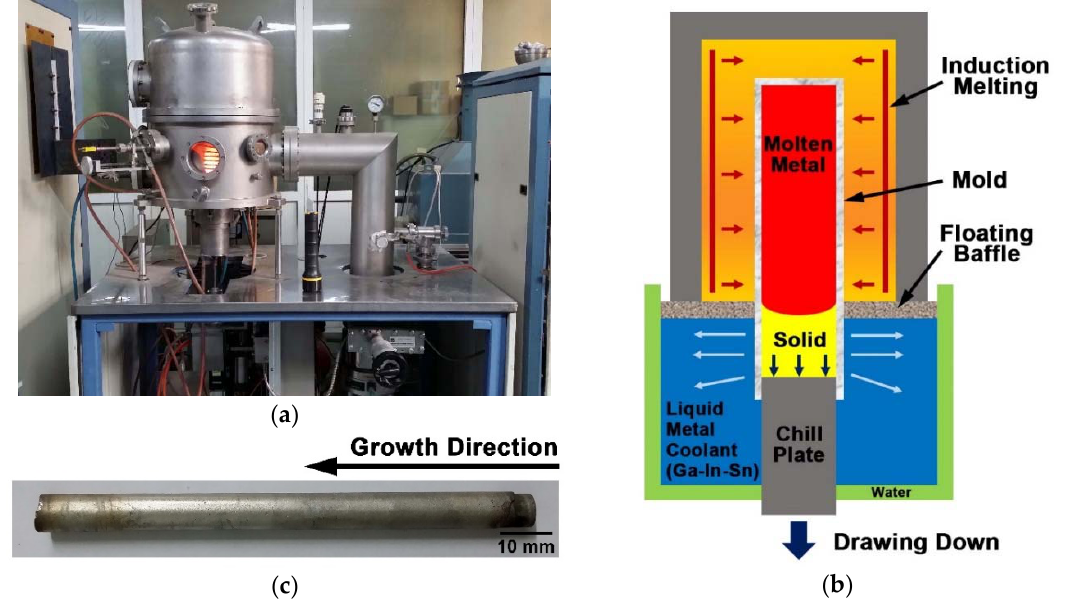
Figure 1. ( a ) Appearance and ( b ) schematic illustration of the liquid metal cooling (LMC) type directional solidification apparatus; ( c ) Optical image of a typical experimental bar after the LMC-DS processing.